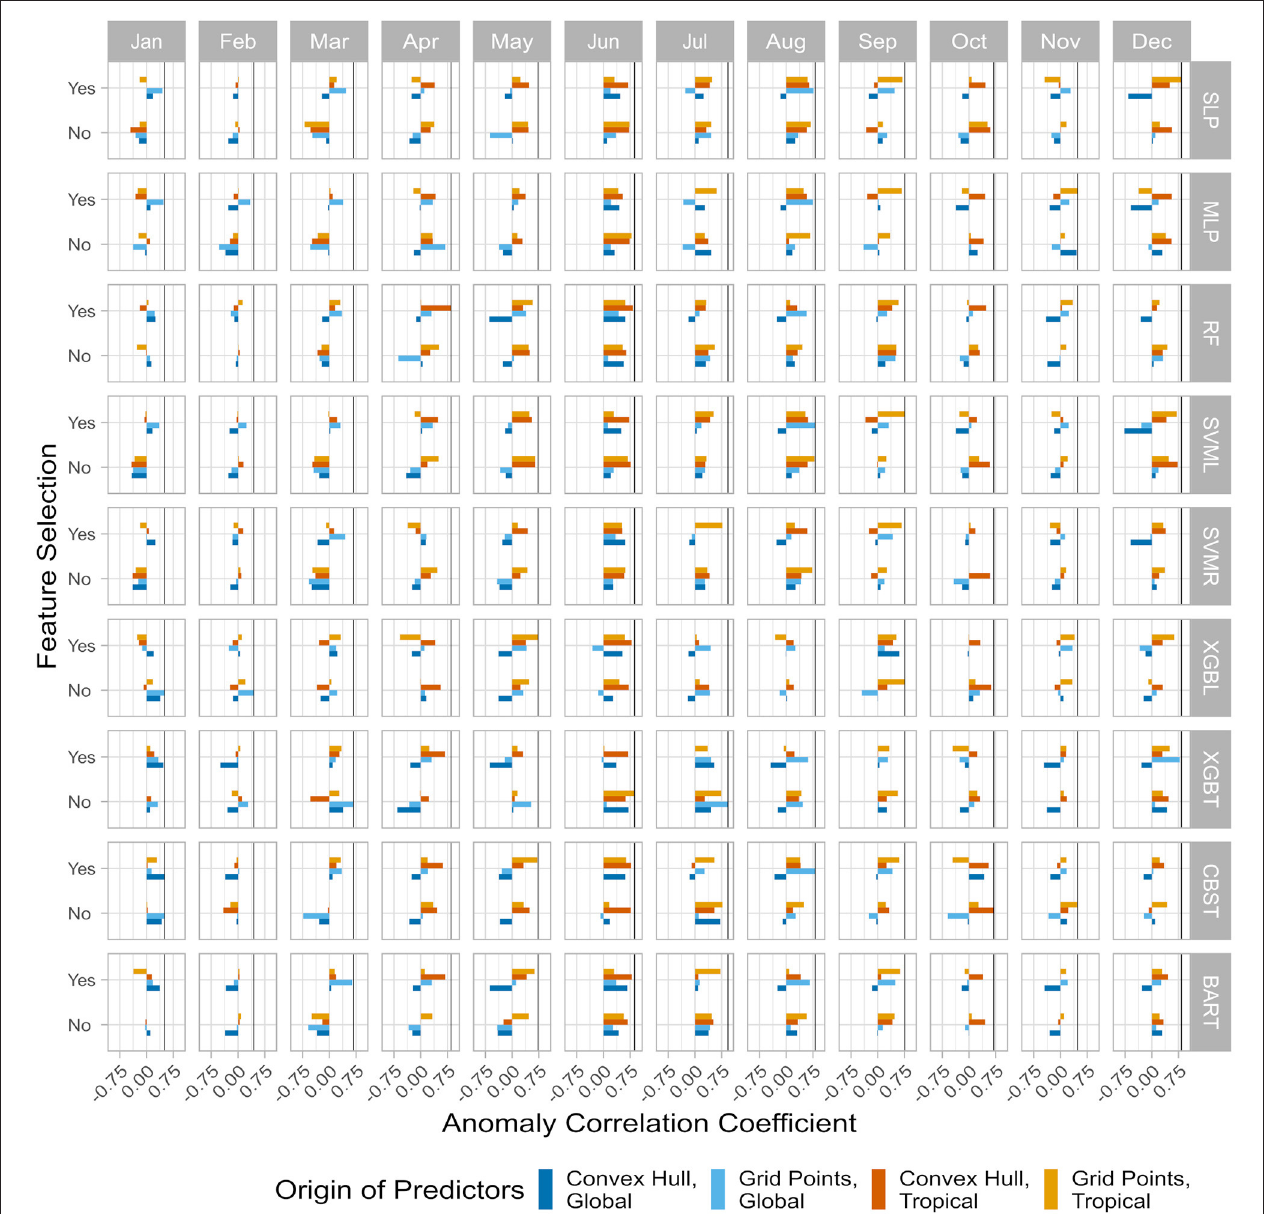
FIGURE 5 | Monthly anomaly correlation coefficients (ACC) between the observed SAT index anomalies in the Kant¯o region and the forecasted SAT index anomalies during the validation period (March 2010 to February 2020). Each row is the results for a machine learning (ML) algorithm for each month (column). “SLP” is the single-layer artificial neural network, “MLP” is the multi-layer (3 layers) version, “RF” is the random forest, “SVML” is the support vector machine with a linear kernel, “SVMR” is the version with a radial kernel, “BART” is the bartMachine implementation of the BART algorithm, “XGBL” is the linear XGBoost implementation of the gradient boosting and “XGBT” is the tree-based XGBoost implementation. ML are run with the selected predictors (“Yes”) or with all the predictors (“No”). The origin of the predictors is provided by the colors. Vertical black lines denote the best coefficient my month.